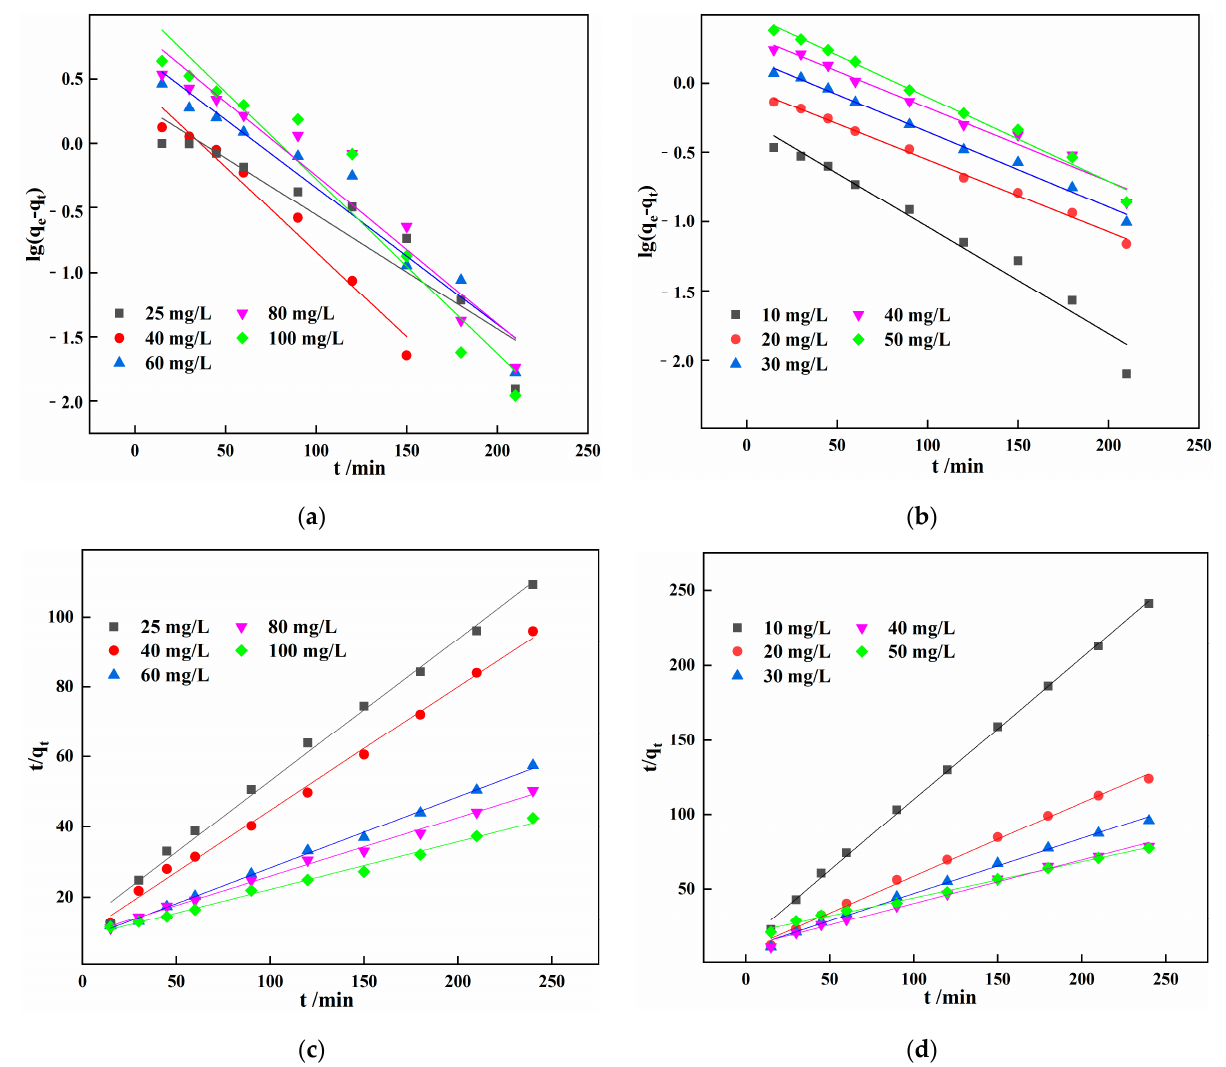
Figure 6. Quasi-first order kinetic equation fitting curve of IHA/TM adsorption of Fe 2+ ( a ) and Mn 2+ ( b ); quasi-second order kinetic equation fitting curve of IHA/TM adsorption of Fe 2+ ( c ) and Mn 2+ ( d ).